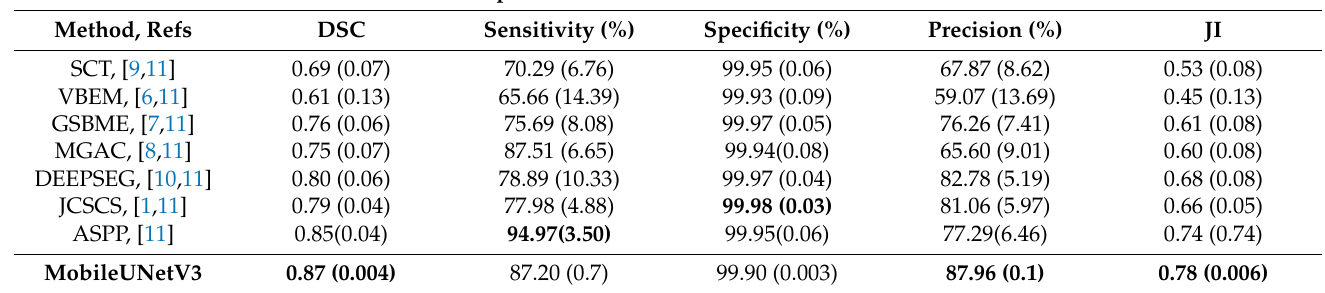
Table 7. Comparison of MobileUNetV3 with seven state-of-the-art methods on the basis of five segmentation metrics. All eight methods were applied in the segmentation of spinal cord gray matter using the same dataset from the SCGM segmentation challenge. The RMSProp optimizer, 400 epochs, and a batch size of 8 were adopted in the experimental runs of our proposed model. DSC and JI stands for dice similarity coefficient and Jaccard index, respectively. Values are displayed in the same format as in [11] to ease